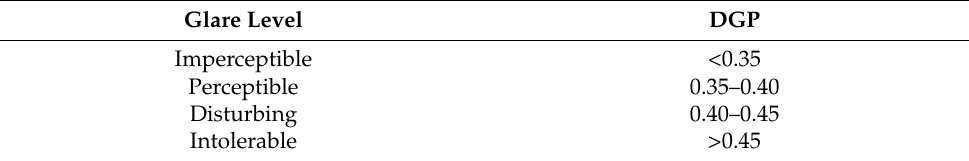
Table 8. DGP glare rating evaluation